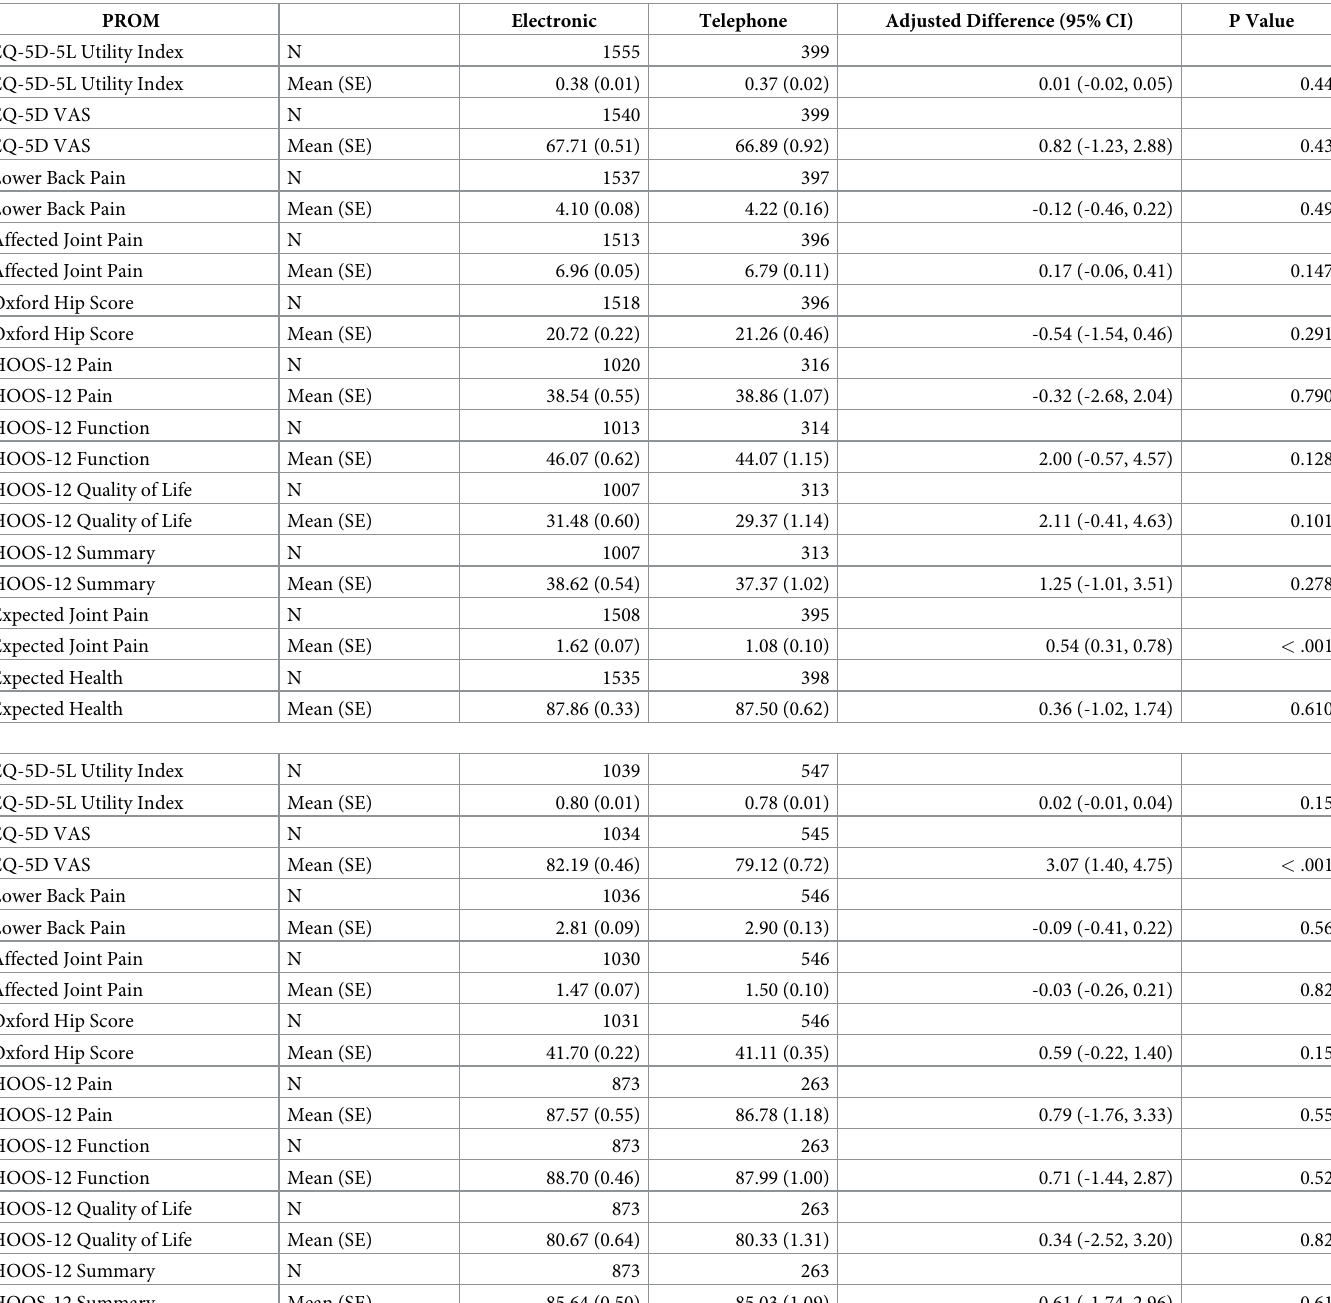
Table 4. a: Pre-Operative Patient-reported outcomes comparing patients responding directly (“electronic”) and those responding by telephone (“telephone”) for patients undergoing THA. b: Post-operative patient-reported outcomes comparing patients responding directly (“electronic”) and those responding by telephone (“telephone”) for patients undergoing